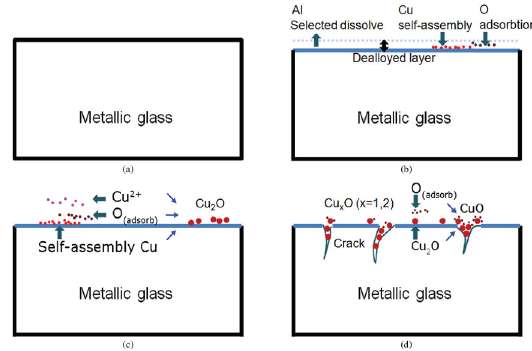
Figure 6. Formation schematic for Cu